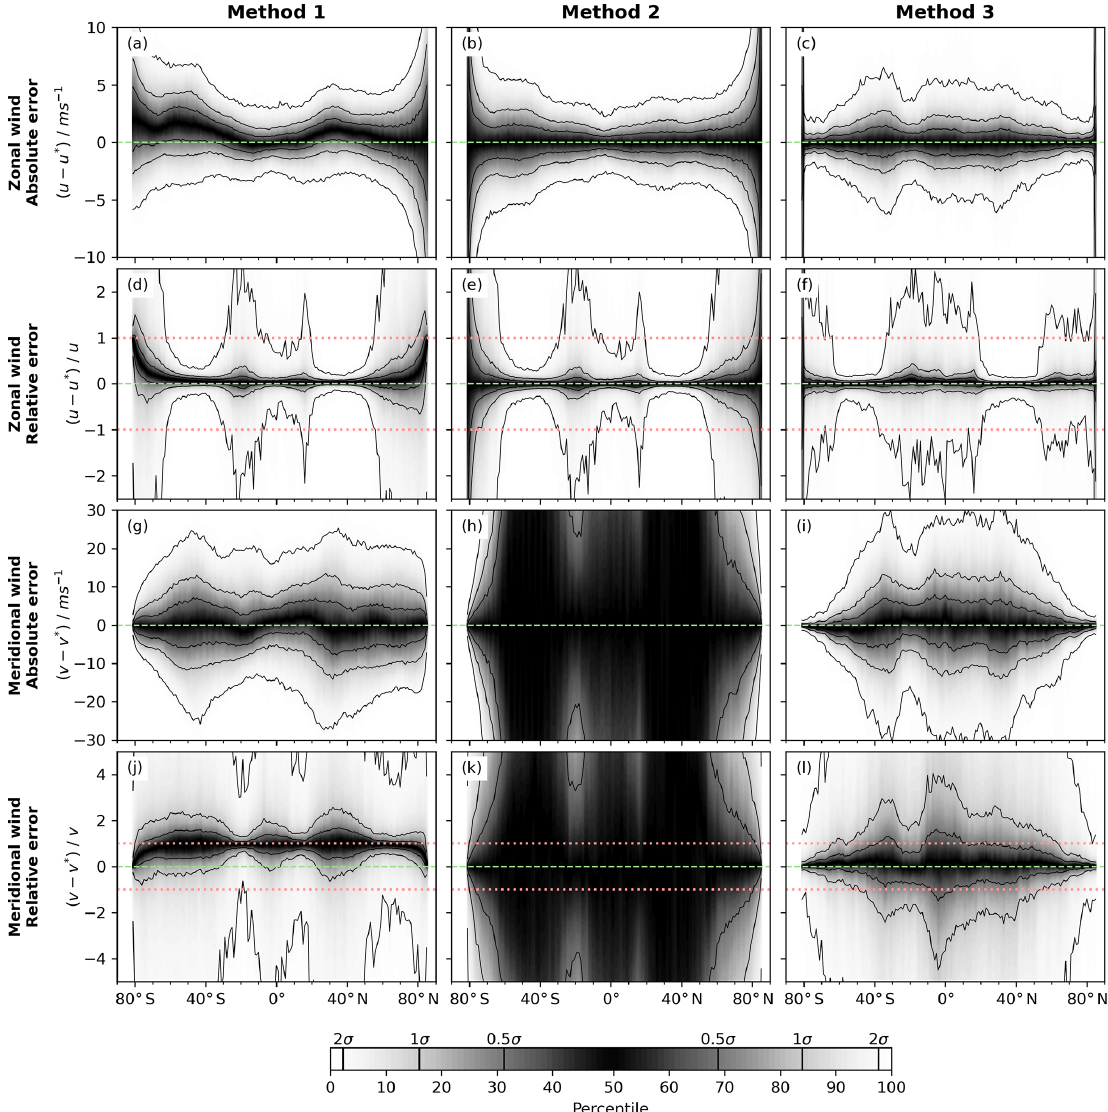
Figure 7. Statistical distribution of absolute and relative errors for the different methods versus latitude ( x -axes). Data from the whole month of January 2021 is used here. The green dashed lines indicate zero absolute and relative wind errors, the red dotted lines in the relative error plots indicate errors of